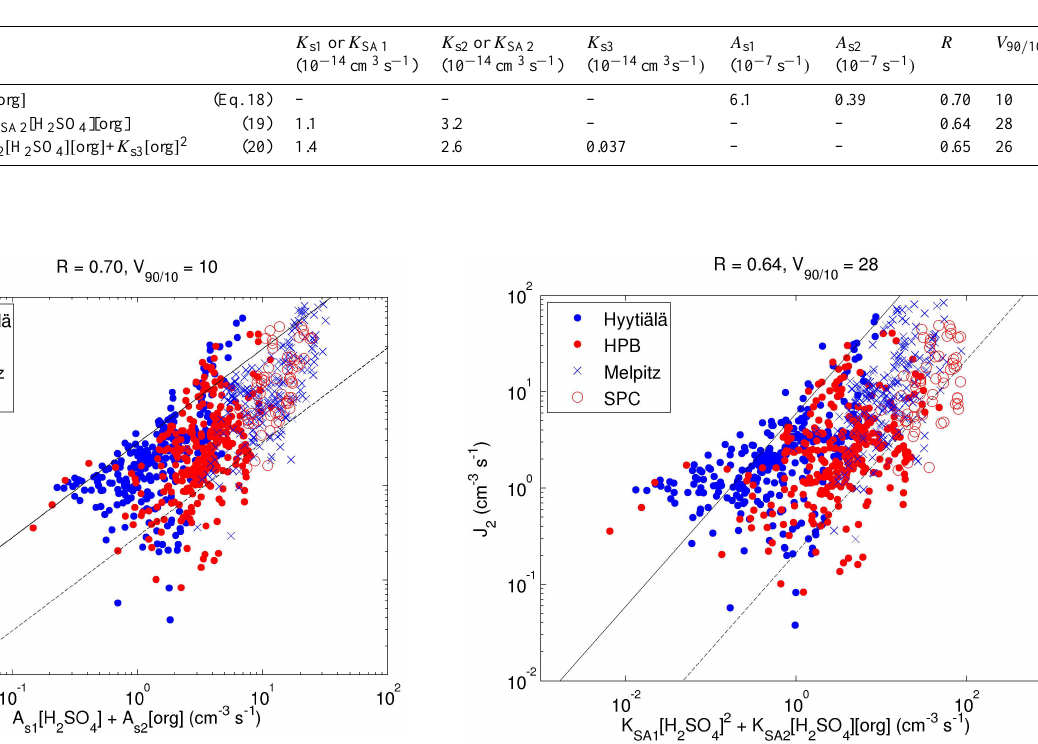
Fig. 9. Neutral particle formation rate J 2 as a function of the sum of the squared sulphuric acid concentration and the product of sulphuric acid and organic vapour concentrations, terms mul- tiplied with separate nucleation coefficients K SA1 =9.5 × 10 − 15 and K SA2 =4.6 × 10 − 14 cm 3 s − 1 . The lines present the 90th (solid) and 10th (dashed) percentile values of the ratio between the observed J 2 and the rate modelled with Eq.